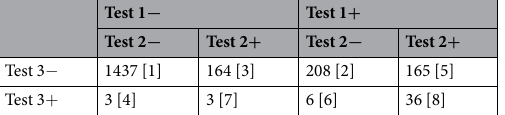
Table 1. Observed frequencies of the eight possible combinations of results from three diagnostic tests used in 2,022 sampling events involving 541 different badgers. Numbers in square brackets identify each of the